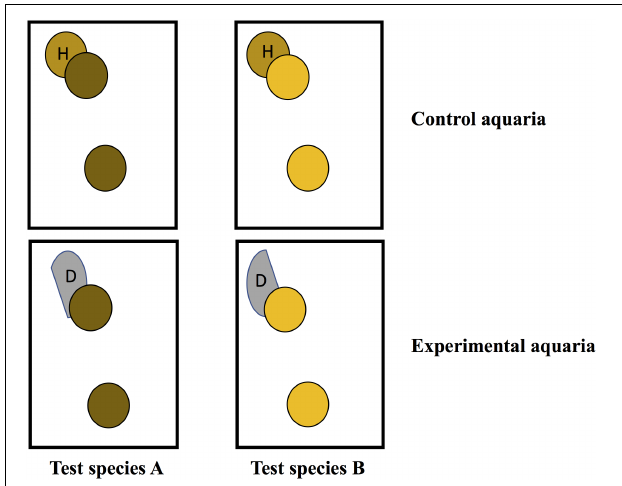
FIGURE 2 | Schematic showing experimental design for transmission studies in aquaria. Circles with the same color indicate coral fragments were collected from the same